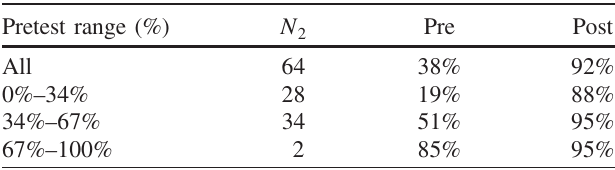
TABLE VII. Percentage average total pretest and post-test scores (matched pairs) divided into three groups according to the pretest performance for the tutorial group. N 2 denotes the total number of students in Sec. II who worked through the tutorial and took both the pretest and post-tests.